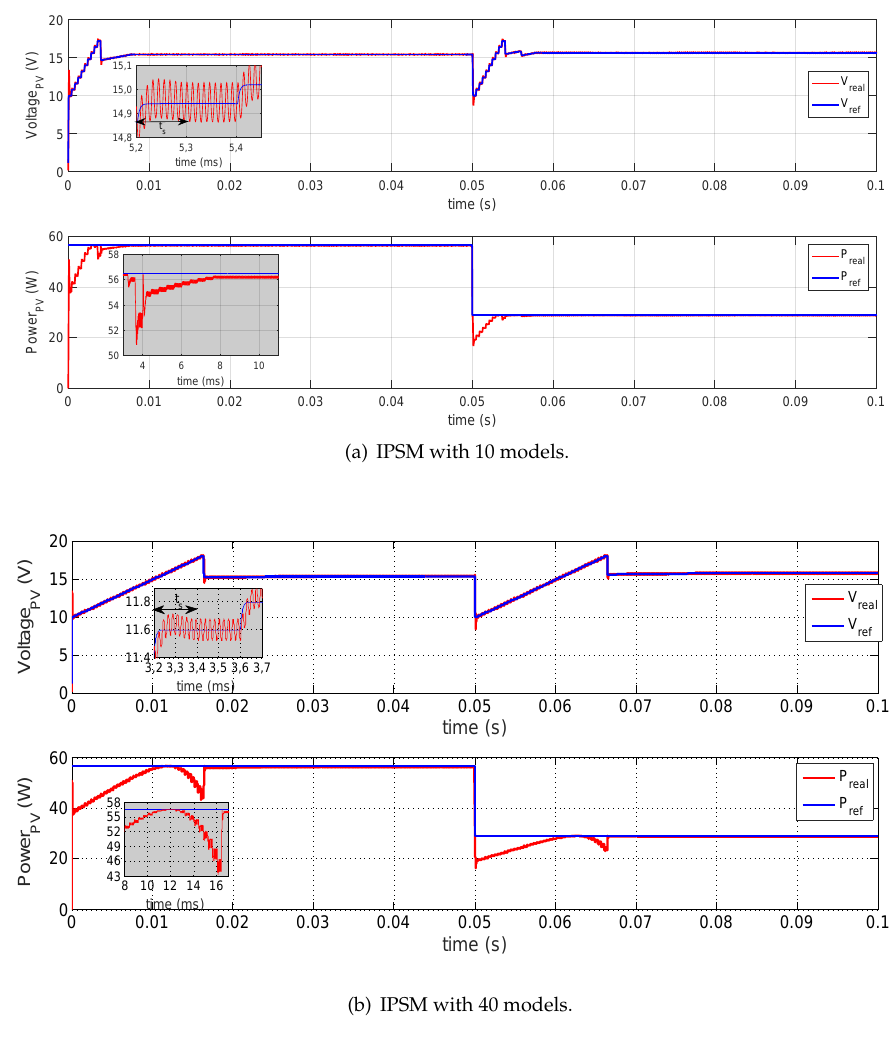
Figure 10. MPPT based in IPSM. Profile of the PV panel voltage and power